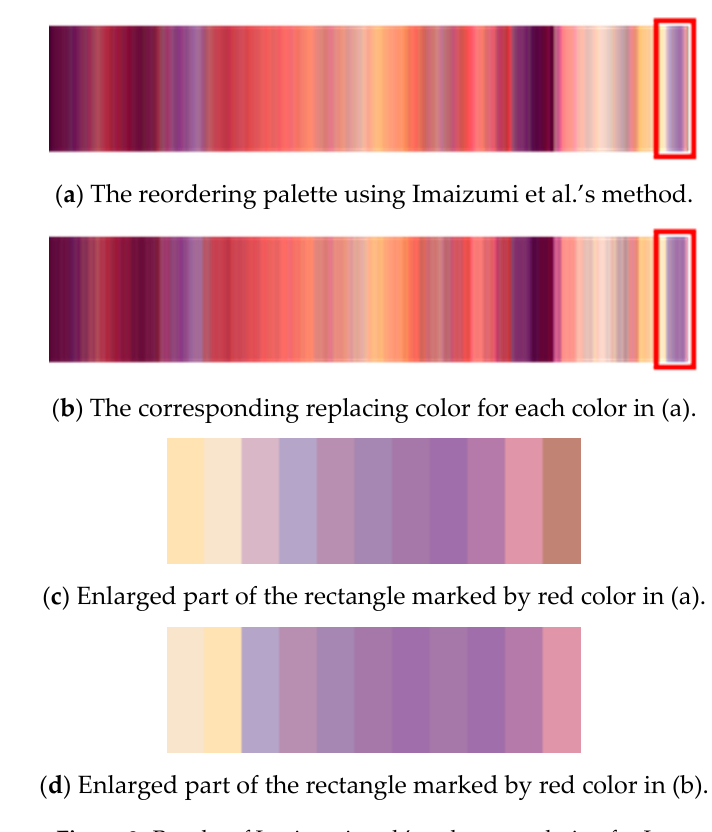
Figure 2. Results of Tanaka et al.’s parity assignment with k = 1 for Lena.